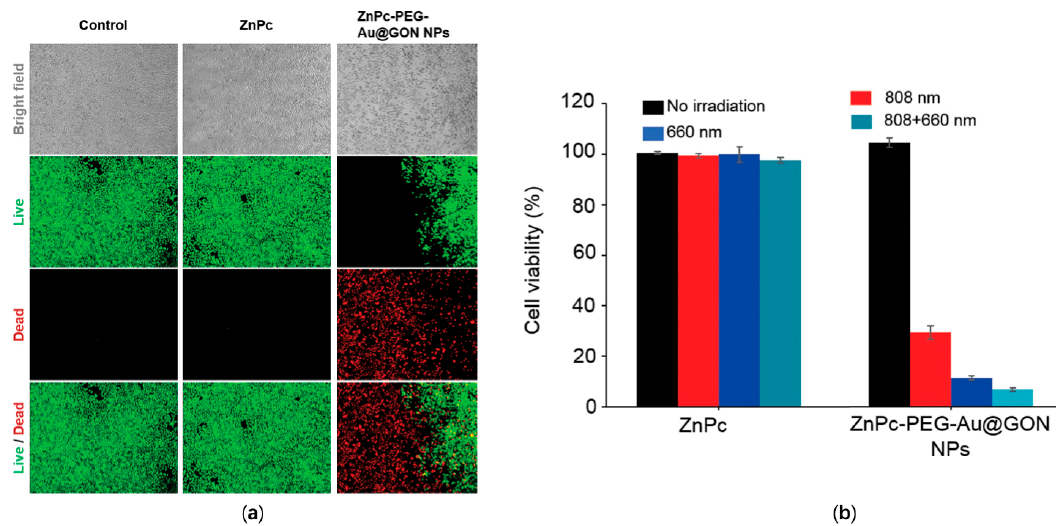
Figure 21. ( a ) Bright-field and fluorescence microscopy images of control, ZnPc, and ZnPc-PEG-Au@GON nanoparticle (NP) treated HeLa cells wgucg were exposed to a 660 nm fiber coupled laser with 67 mW/cm 2 for 15 min and subsequently stained by a lince/Dead assay reagent, green: live cells, red: dead cells. ( b ) Cell viability of HeLa cells treated with ZnPc, and ZnPc-PEG-Au@GON NPs and subsequent exposure to 808 nm with 0.67 W/cm 2 for 20 min, 660 nm with 0.2 W/cm 2 for 10 min, or both light sources with the same condition, sequentially [98].